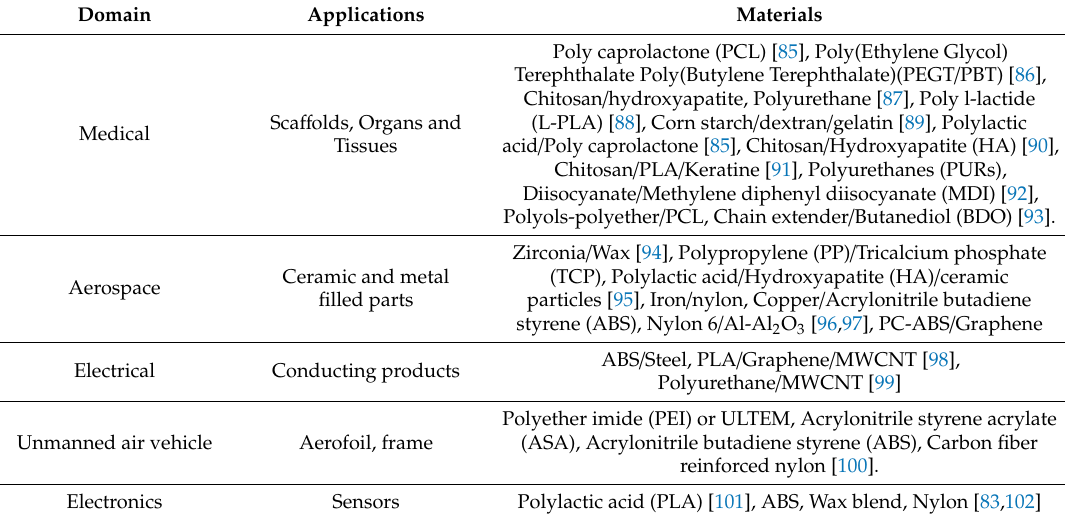
Table 1. Fused filament fabrication (FFF) materials for di ff erent applications that are not generally investigated for tensile